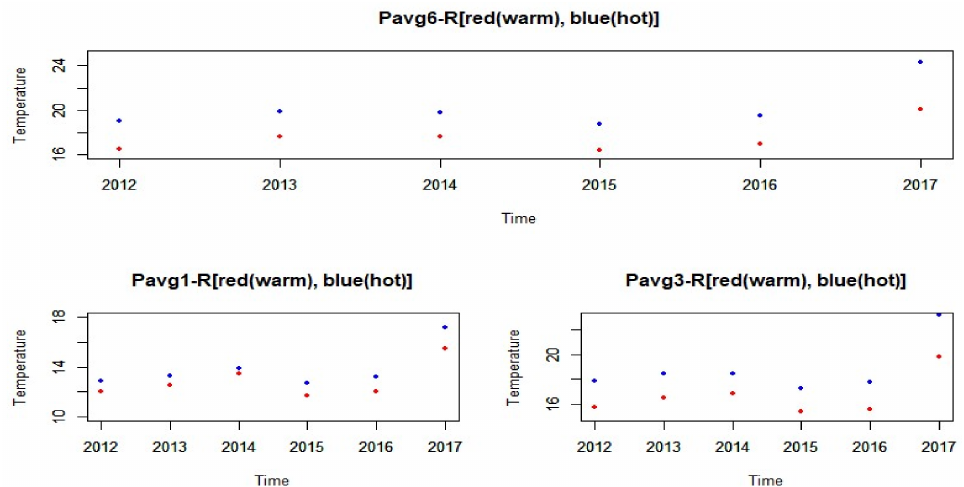
Figure 37. RCP 8.5 hot model (MIROC-ESM-CHEM) and RCP 8.5 warm model (IPSL-CM5A-MR) predictions for the period 2012–2017 (full dam steady-state), temperature in ◦